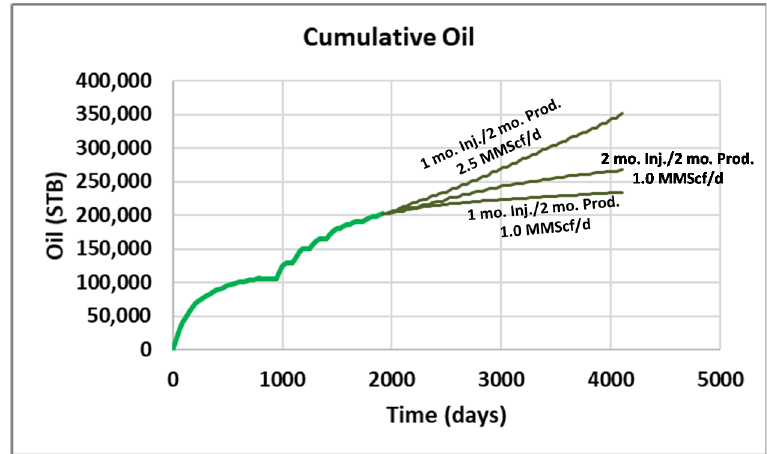
Figure 25. Total oil production when combining shorter injection cycles with higher injection